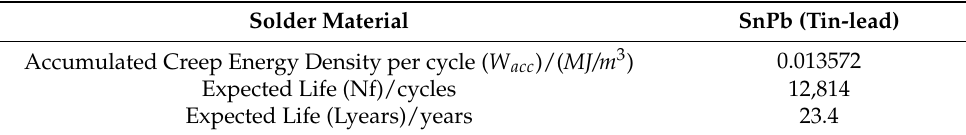
Table 5. Expected Life of solder interconnects from outdoor module (TRA) temperature cycle profile. Solder Material SnPb (Tin-lead) Accumulated Creep Energy Density per cycle ( W acc )/( MJ/m 3 ) 0.013572 Expected Life (Nf)/cycles